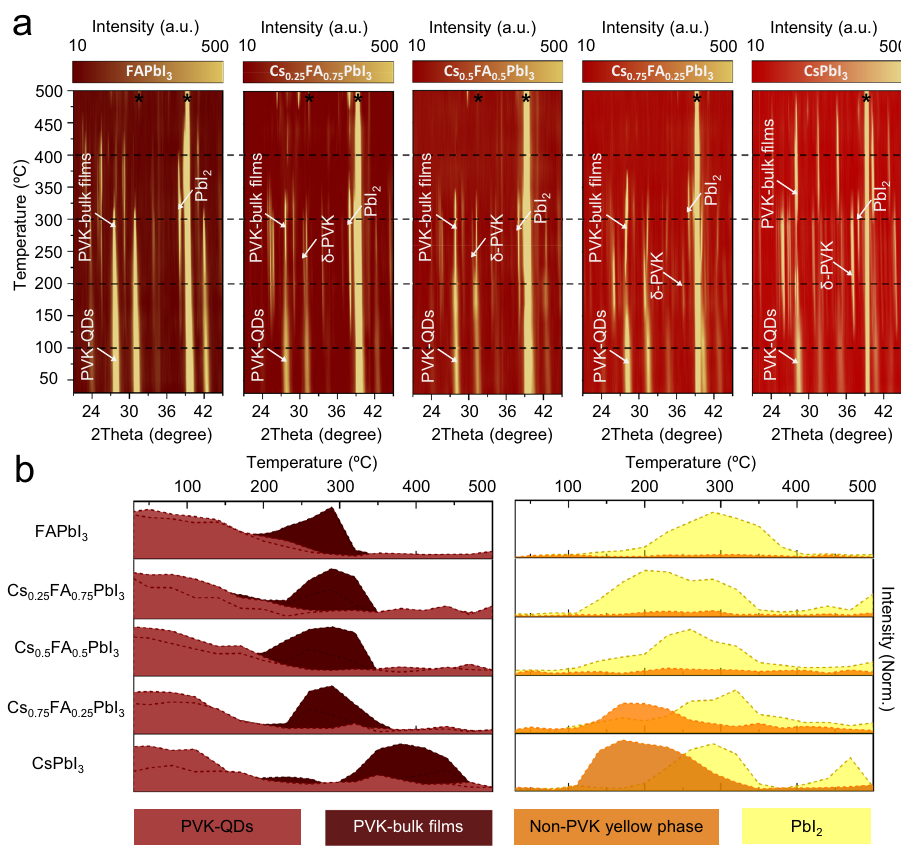
Fig.1|InsituXRDanalysesofCs x FA 1-x PbI 3 PQDs.a InsituXRDpatternscollected from 30°C to 500°C under argon fl owing for FAPbI 3 , Cs 0.25 FA 0.75 PbI 3 , Cs 0.5 FA 0.5 PbI 3 , Cs 0.75 FA 0.25 PbI 3 , and CsPbI 3 PQDs. b Scheme for the dominant re fl ectionsinthethermaldegradationofCs x FA 1-x PbI 3 PQDsthataredrawnfromthe in situ XRD data taken at the 2 θ angles shown in Supplementary Table 1 for